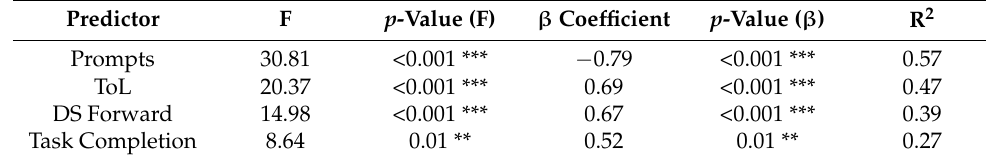
Table 7. Linear regression: best models for predicting system’s perceived usability. Predictor